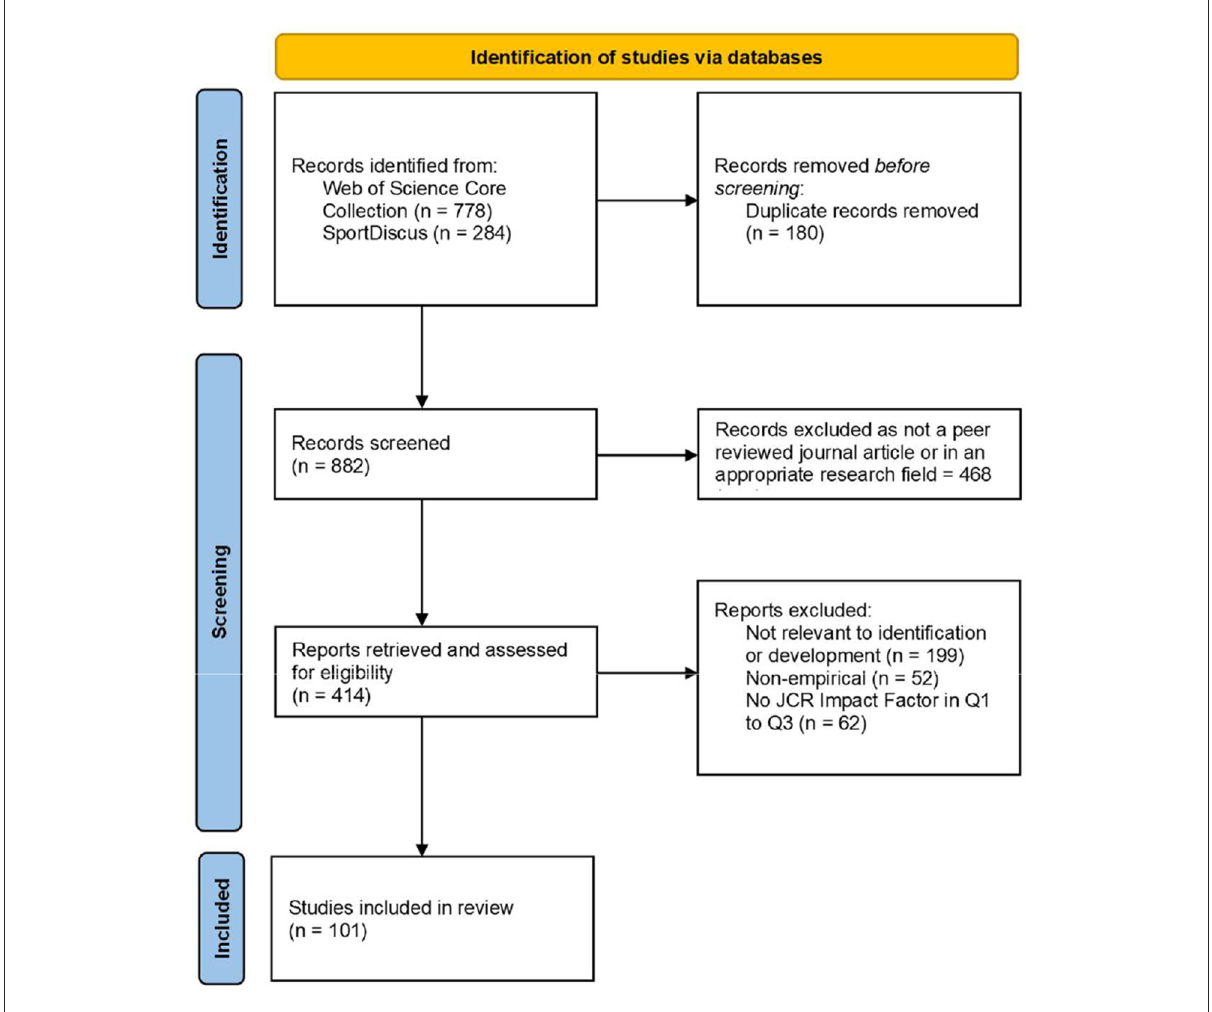
FIGURE1 PRISMA flow diagram of the search